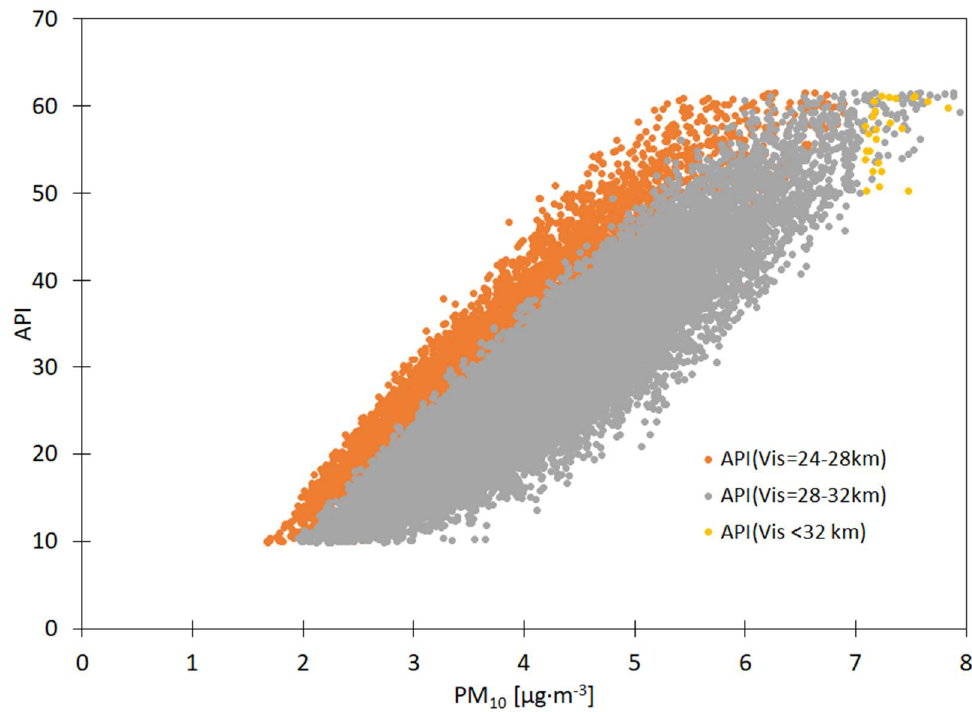
Figure A8. Effect of visibility-dependent PM 10 air concentrations on the air pollution index for the rainy summer season.